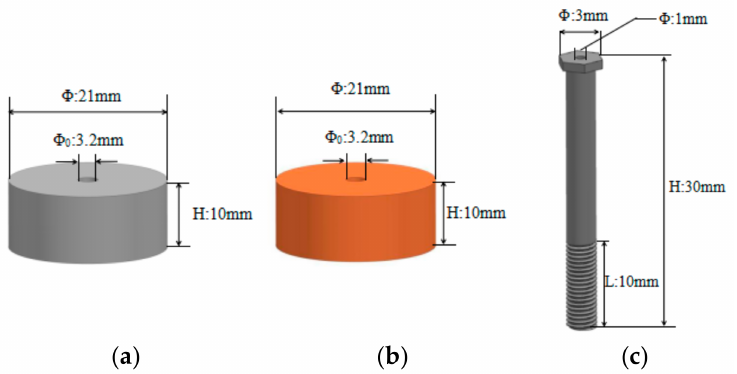
Figure 4. Resonance body structural parts, ( a ) mass block ( b ) elastomer ( c )